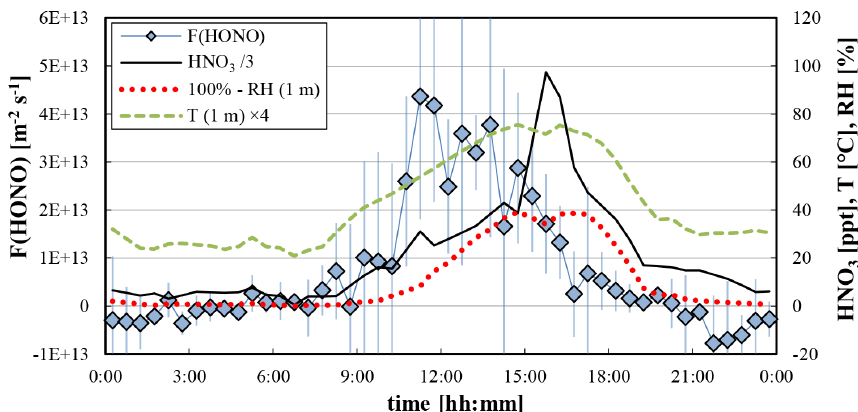
Figure 7. Average diurnal profiles of the HONO flux, HNO 3 mixing ratio, and the relative humidity (100% − RH) and temperature of the air at 1m height. Error bars represent the standard deviation of the HONO fluxes of the four